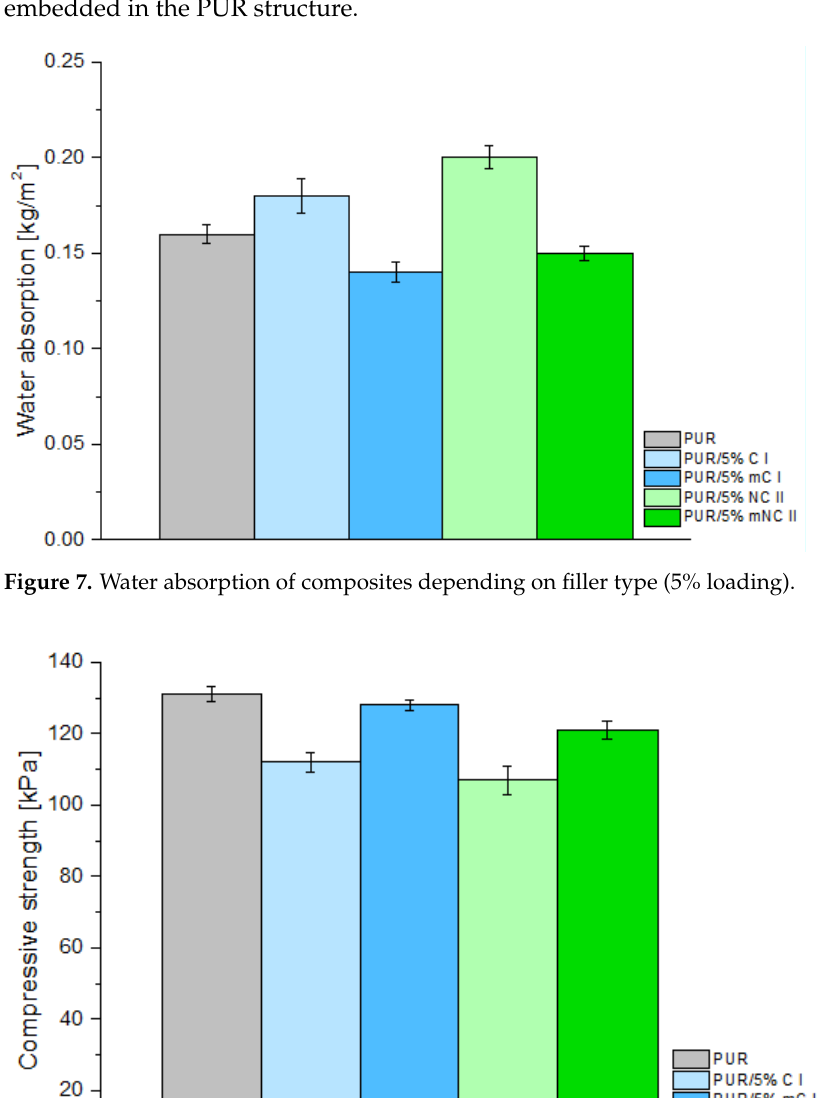
Figure 8. Compression strength of composites depending on filler type (5% loading).